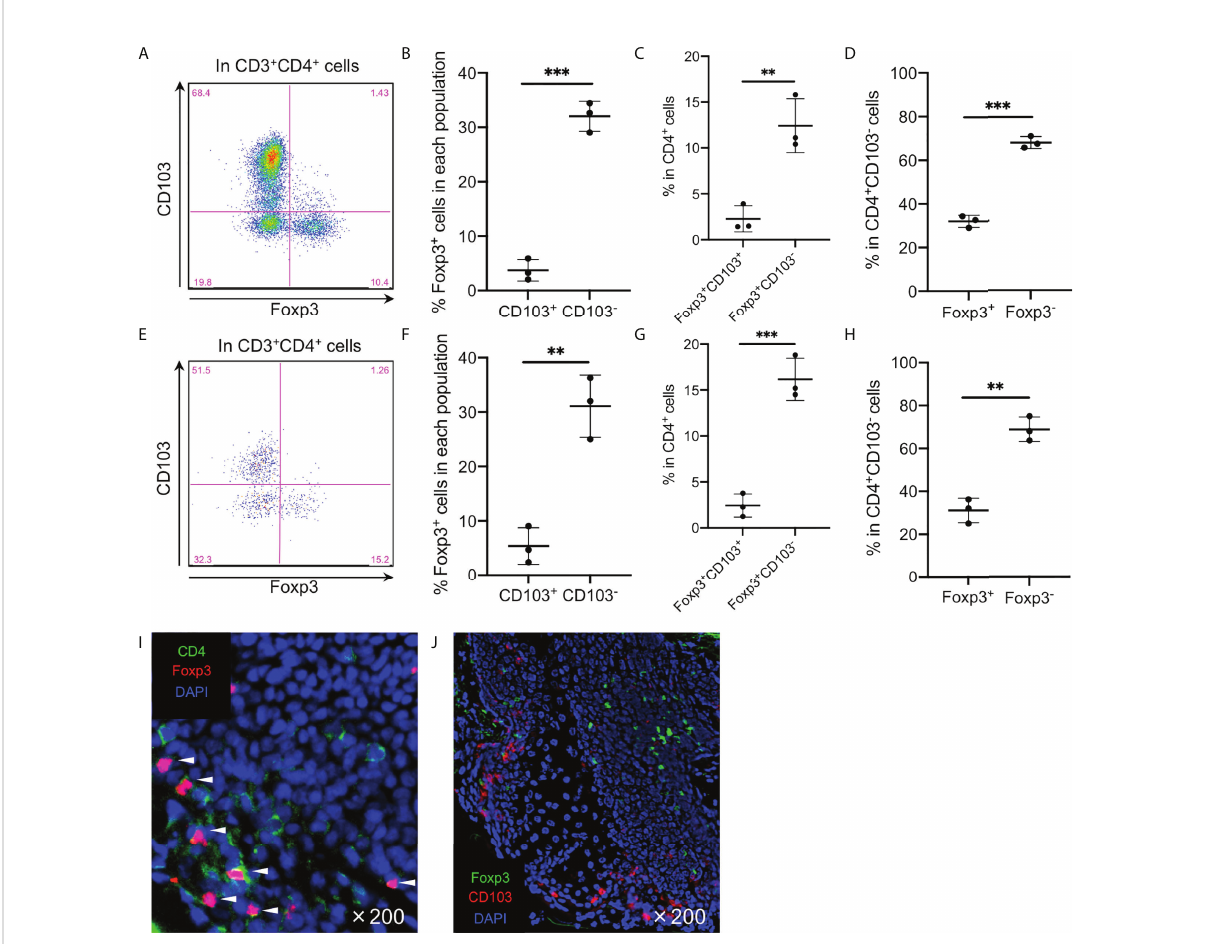
FIGURE 2 Predominant Foxp3 expression in the epidermal CD4 + CD103 − cells. (A, E) Representative Foxp3 and CD103 expression in the CD3 + CD4 + cells. (B, F) A summary of percentage of Foxp3 + cells in the epidermal CD103 + and CD103 − cells. (C, G) A summary of the indicated population percentage in the epidermal CD3 + CD4 + cells. (D, H) A summary of the indicated population percentage in the epidermal CD3 + CD4 + CD103 − cells. (A-D) analyzed CD3 + CD4 + cells of epidermal emigrants, whereas (E-H) analyzed CD3 + CD4 + cells of enzymatically digested epidermal single-cell suspensions. (I, J) Representative CD4 and Foxp3 staining (I) and Foxp3 and CD103 staining (J) in normal skin. All the experiments were conducted using at least three different samples. Comparisons between groups were evaluated using Student ’ s t -test (one-tailed); ** p < 0.01 and *** p < 0.001. Arrowheads in (I) indicate costained cells in the